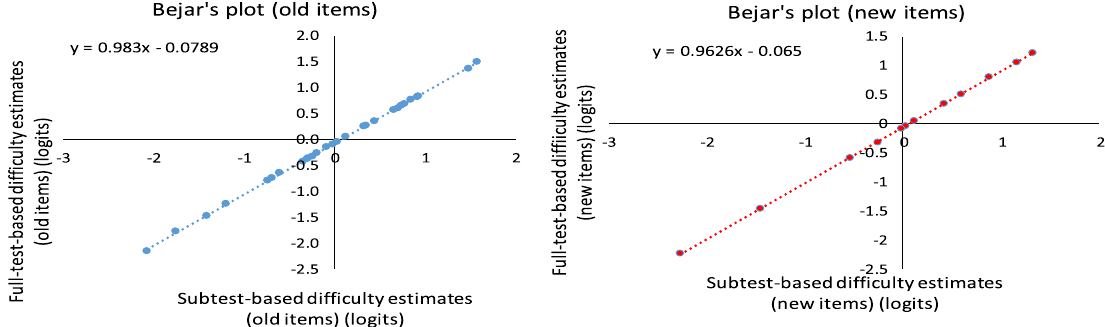
FIG. 2. Cross plots for full-test-based vs subtest-based estimates of item difficulties for “ old ” and “ new ”